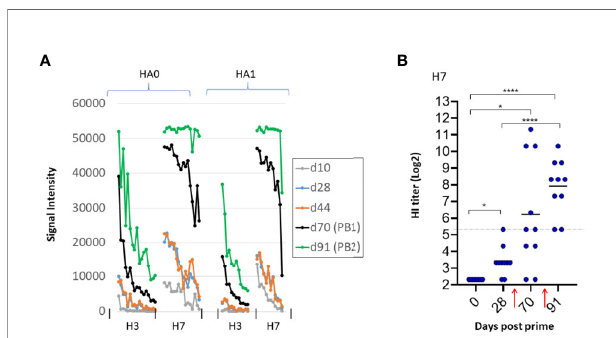
FIGURE 7 | Higher antigen dose overcomes bar to induction of heterosubtypic cross-reactivity. B6 mice (N=10) were administered high dose trivalent vaccine (10 m g each of Cal09 H1 + VN04 H5 + AH13 H7) in IVAX-1 adjuvant on d0; H7 cross-reactivity for H3 (not present in the vaccine) appears after boosting. (A) IgG pro fi les of H7 (present in the vaccine) and H3 (not present in the vaccine) at different time points. H3 signals (hetero-speci fi c cross-reactivity) are elevated after boosting. Contrast with lower dose in Figure 6 where no elevation was seen after boosting. (B) HI assay titers of individual plasma used in (A) against PR8 reassortant in fl uenza virus expressing AH13 H7 shows boosting is required for appearance of HI activity.